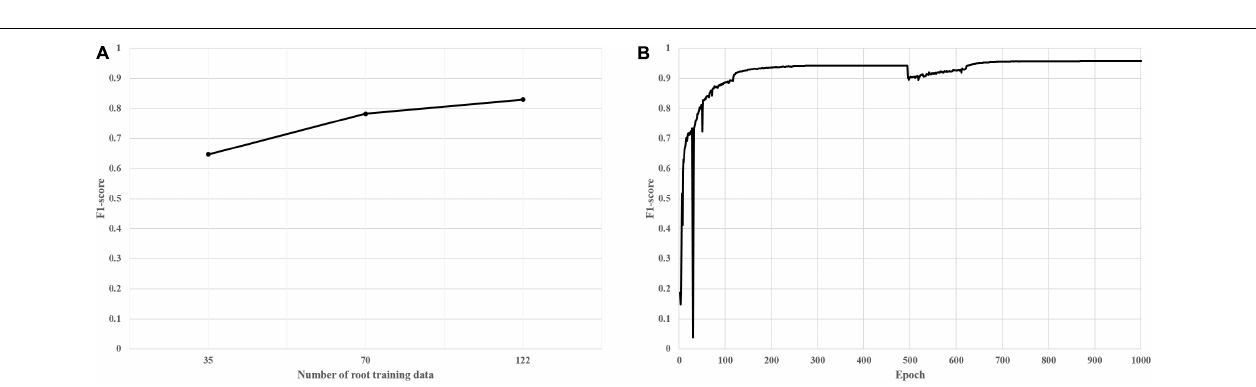
FIGURE 5 | Semi-automatic annotation function-based error correction. (A) confirm of error nodules (B) error correction; red rectangles (C) segmentation result (mask image) before error correction (D) segmentation result after error correction.